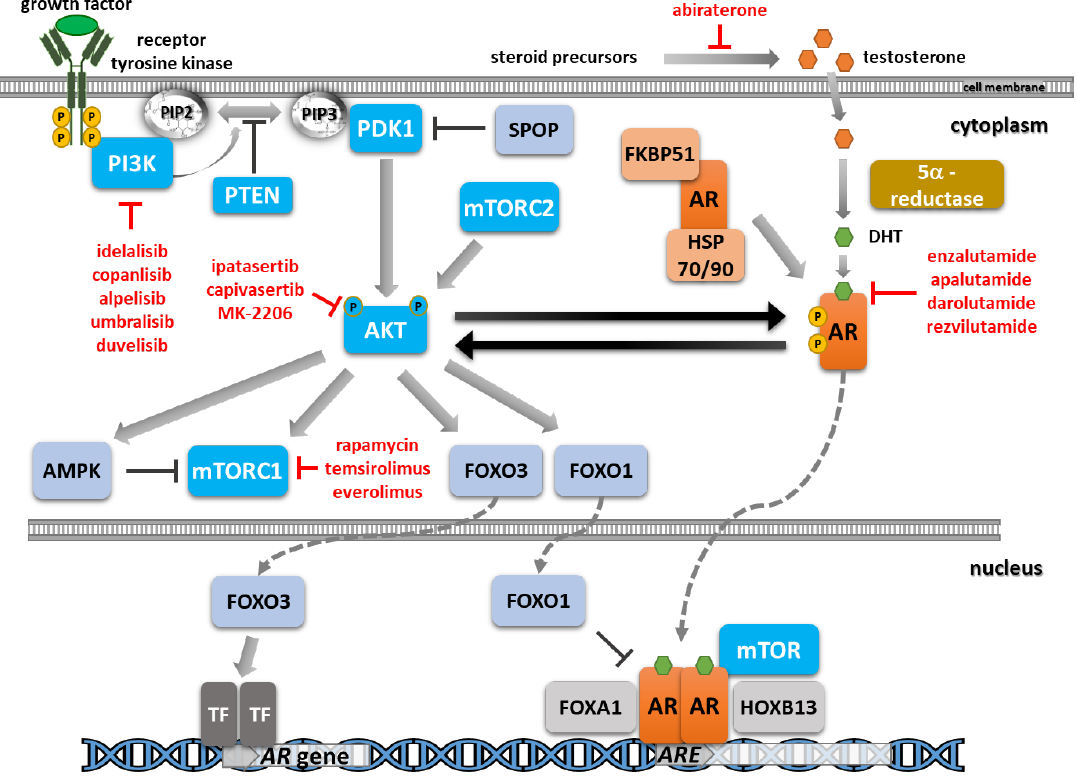
Figure 1. Schematic overview of the AR and PI3K/AKT/mTOR signaling pathways and their crosstalk. Selected approved and advanced inhibitors addressing these pathways are indicated.